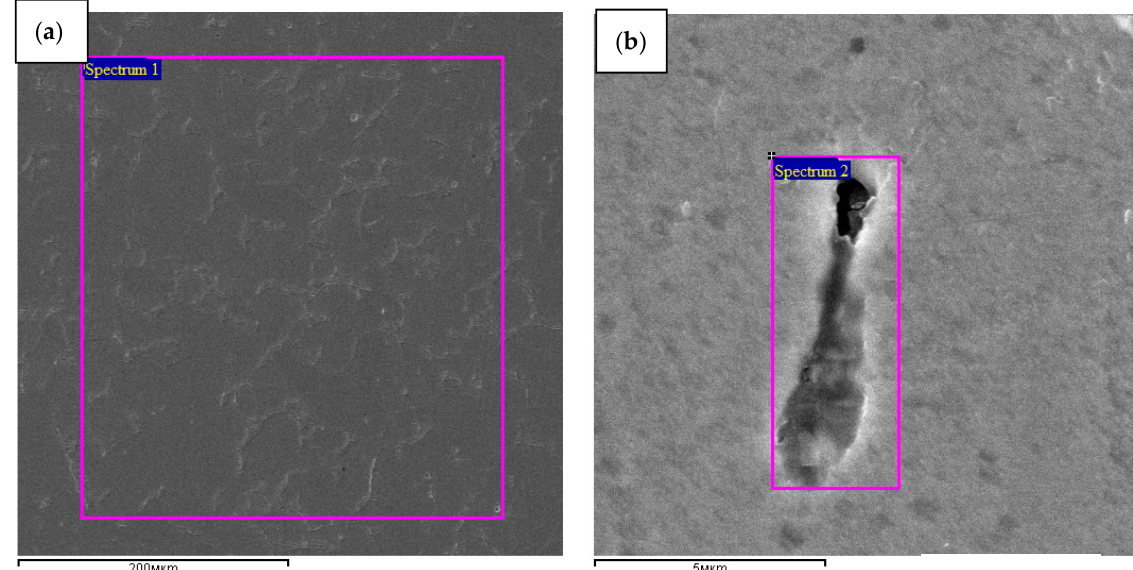
Figure 6. Zones of composition analysis ( a ) the initial steel 3 and ( b ) channel element(fiber) section in steel 3 after dynamic alloying with SiC powder in the SDP